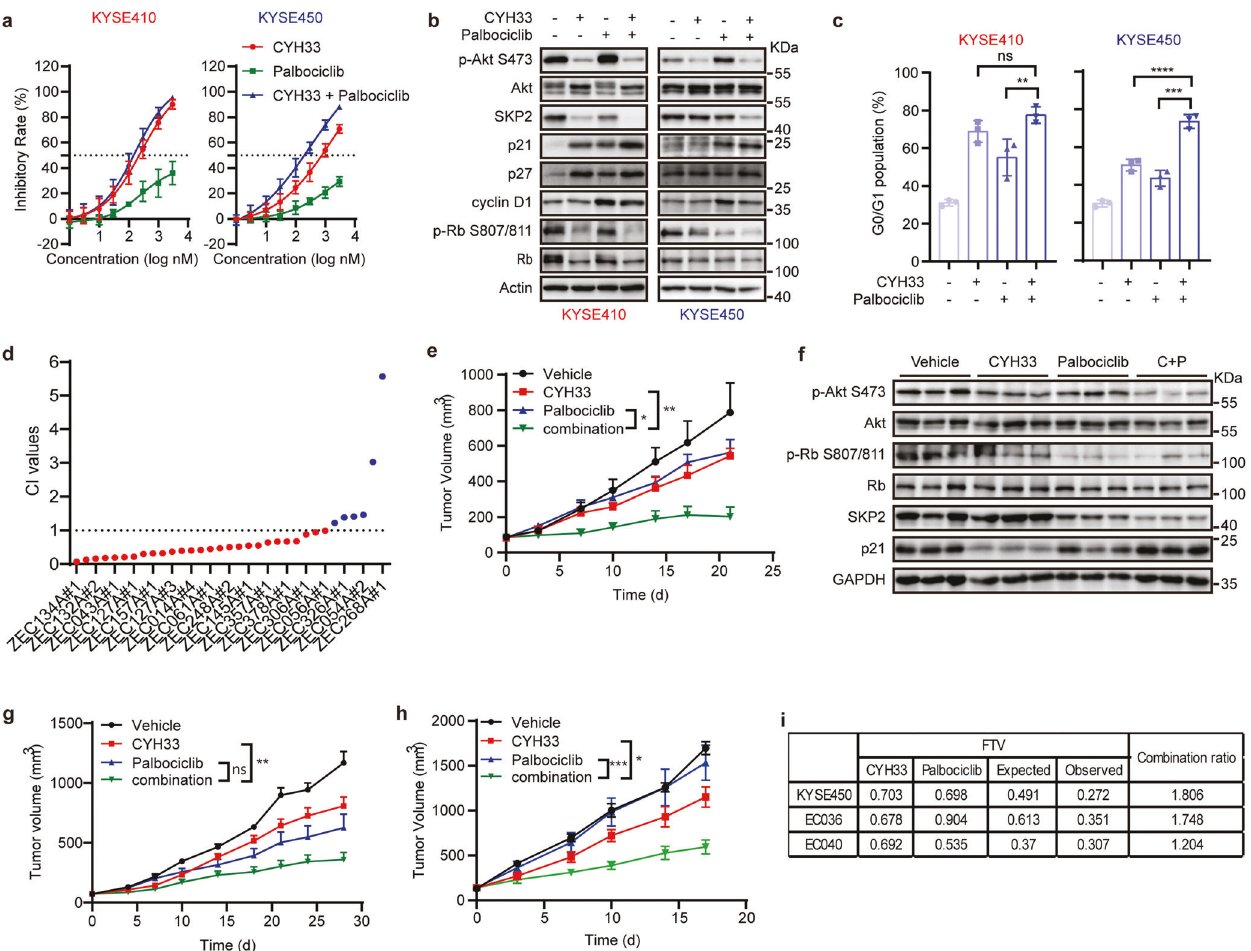
Fig. 6 CDK4/6 inhibitors sensitized ESCC to CYH33. a KYSE410 and KYSE450 cells were treated with CYH33 and palbociclib alone or concurrently for 72 h. Cell proliferation was measured by SRB assay and combination index (CI) values were determined by CalcuSyn software ( n = 3). b , c KYSE410 and KYSE450 cells were exposed to CYH33 (1 μ M) and palbociclib (1 μ M) alone or concurrently for 24 h. Cell lysates were then subjected to Western blot with the indicated antibodies ( b ) and cell cycle distribution was analyzed by fl ow cytometry ( c , n = 3). Differences between the indicated groups were analyzed using two-tailed one-way ANOVA with Tukey multiple group comparison test. ns, p > 0.05; ** p < 0.01; *** p < 0.001; **** p < 0.0001. d A panel of 33 lines of ESCC PDCs were treated with CYH33 and abemaciclib alone or concurrently in duplicate wells with a 9-concentration gradient for 72 h. Cell proliferation was assessed by CellTiter-Glo assay and CI values were determined by CalcuSyn software. e , f Randomly grouped BALB/c nude mice bearing KYSE450 xenografts were administrated orally with vehicle control, CYH33 (10 mg/kg), palbociclib (50 mg/kg), or a combination of CYH33 and palbociclib once a day for 21 days ( n = 5). e Tumor volume was measured twice a week. Data were presented as mean + SEM. Differences between the indicated groups were analyzed using two-tailed one-way ANOVA with Tukey multiple group comparison test. * p < 0.05; ** p < 0.01. f Three representative tumors from each group were homogenized and then subjected to Western blot with the indicated antibodies. g , h Randomly grouped BALB/c nude mice bearing ESCC PDX EC040 ( g ) or EC036 ( h ) were administrated orally with a vehicle control, CYH33 (10 mg/kg), palbociclib (50 mg/kg), or a combination of CYH33 and palbociclib once a day for 28 or 17 days ( n = 6). Tumor volume was measured twice a week. Data were presented as mean + SEM. Differences between the indicated groups were analyzed using two-tailed one-way ANOVA with Tukey multiple group comparison test. ns, p > 0.05; * p < 0.05; ** p < 0.01, *** p < 0.001. i The combination ratio of CYH33 and palbociclib in KYSE450, EC040, and EC036 xenografts was determined according to the Bliss independence and CDK2. Hypo-phosphorylation of Rb attenuated E2F1-mediated DISCUSSION transcriptional activation of SKP2, which in turn hindered SKP2- Hyper-activation of PI3K pathway is frequently found in ESCC, mediated degradation of p21 and reinforced accumulation of p21. making PI3K a potential target for treating ESCC. However, the Our work suggests an important role of intact G1/S transition by response to PI3K inhibitors varies among ESCC patients, which p21-Rb-E2F1-SKP2 positive feedback loop in determining sensi- spurs the identi fi cation of biomarkers that might predict or tivity to PI3K α inhibitors in ESCC cells (Fig. 7). We also monitor the clinical ef fi cacy. In this study, we revealed that ESCC demonstrated that concurrent inhibition of CDK4/6 sensitized PDXs with CCND1 ampli fi cation were more sensitive to PI3K α resistant ESCC cells and PDXs to CYH33. inhibitor CYH33. In addition, representative CYH33-sensitive ESCC PIK3CA mutation has been recommended as a sensitive cells displayed higher level of cyclin D1 as well as other regulators biomarker for the approved PI3K α inhibitor alpelisib in combina- in charge of G1/S transition than resistant cells. CYH33 arrested tion with fulvestrant for the treatment of HR-positive, HER2- sensitive ESCC cells in G1 phase by accumulating p21, which negative advanced breast cancer. 13 Accordingly, we found that suppressed Rb phosphorylation by blocking the activity CDK4/6